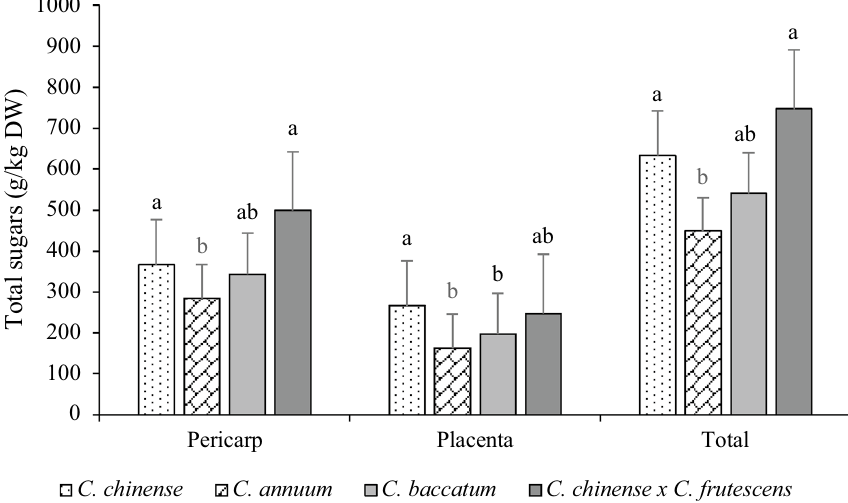
Figure 2. Total sugars (g/kg DW, mean ± SE) in three different species and two chili fruit parts. *a,b lower case letters denote statistical significant differences (α < 0.05) between total sugars in placenta, pericarp and whole fruit between species.